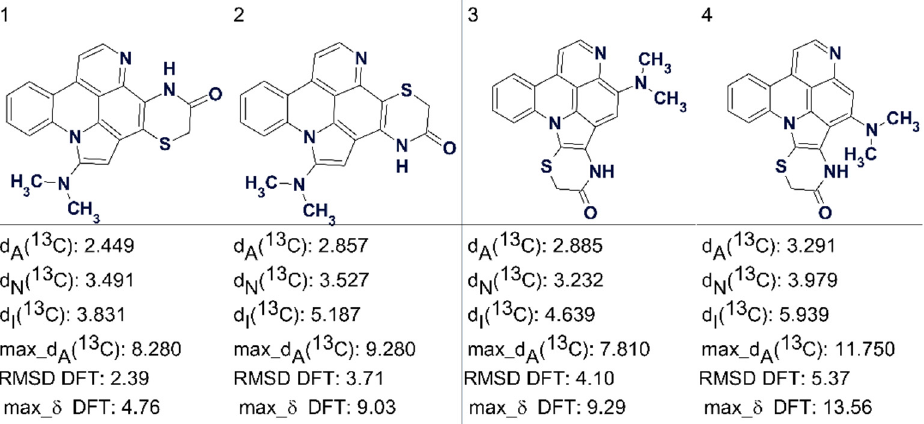
Figure 22. Top ranked plausible structures suggested by the ACD/SE program for cycloshermila- mine D. Notations are similar to those listed in Figure